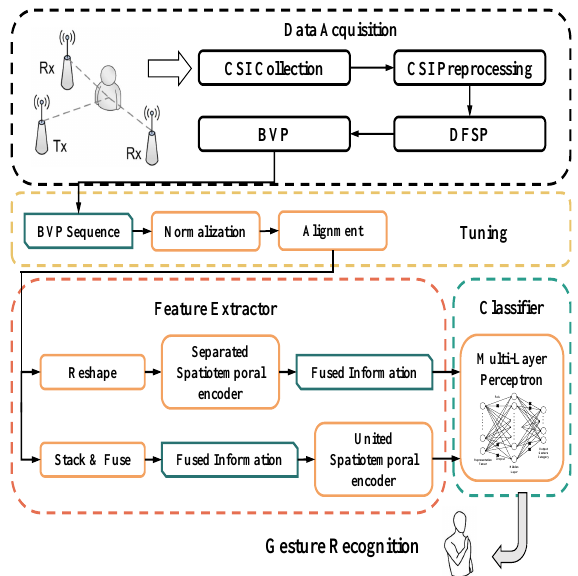
Figure 7. Overall flow chart of the WiTransformer